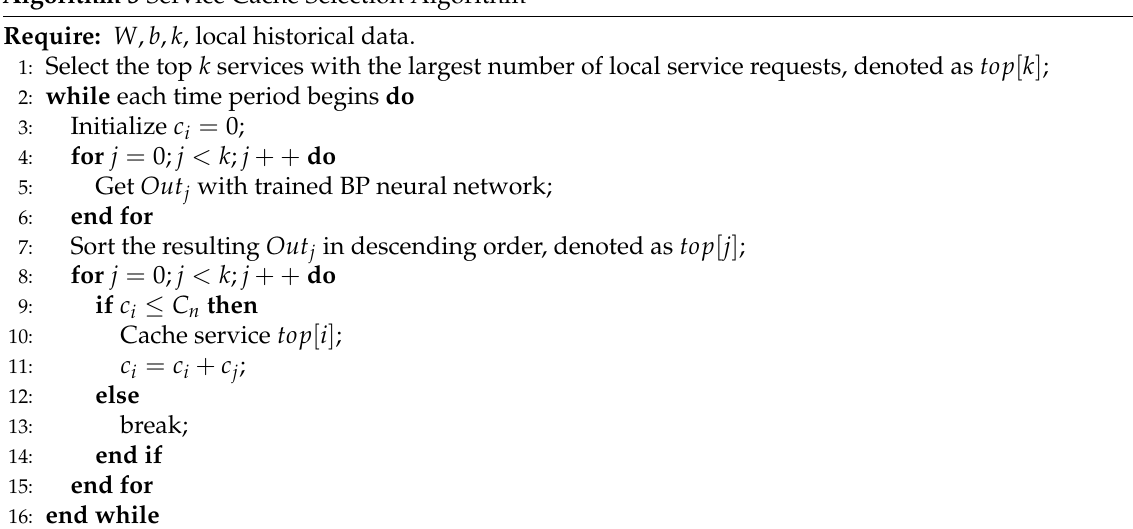
Algorithm 3 Service Cache Selection Algorithm